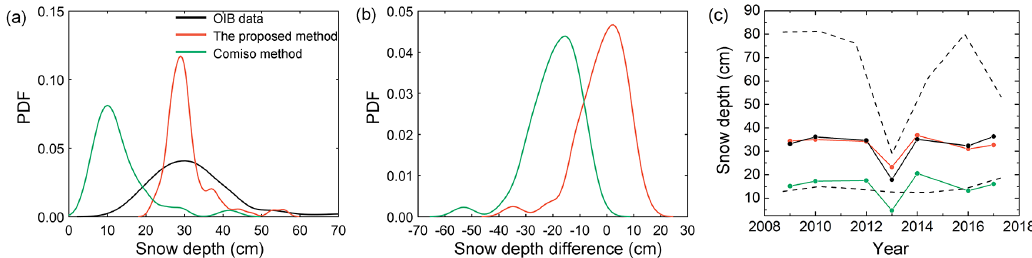
Figure 4. Comparisons of OIB snow depth to the snow depth estimates from both the proposed method and Comiso method. (a) The distributions of snow depth estimates in October 2016, (b) the probability density functions (PDFs) of differences between different snow depth estimates in October 2016 (red: the proposed method – OIB; green: Comiso method – OIB) and (c) the temporal variations in averaged snow depth estimates from 2009 to 2017 (red: the proposed method; green: Comiso method; black: OIB data). The black dashed lines in (c) show the variations in the maximum and minimum snow depth estimates from